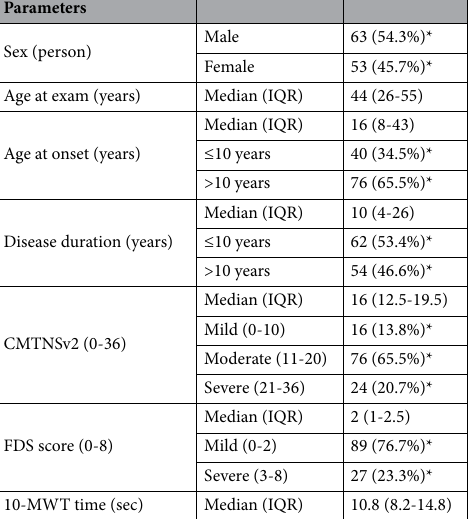
Table 1. Clinical and demographic data of patients with Charcot-Marie-Tooth disease type 1A. *Data are expressed as the number of patients with percentages in parentheses. CMTNSv2 Charcot-Marie-Tooth